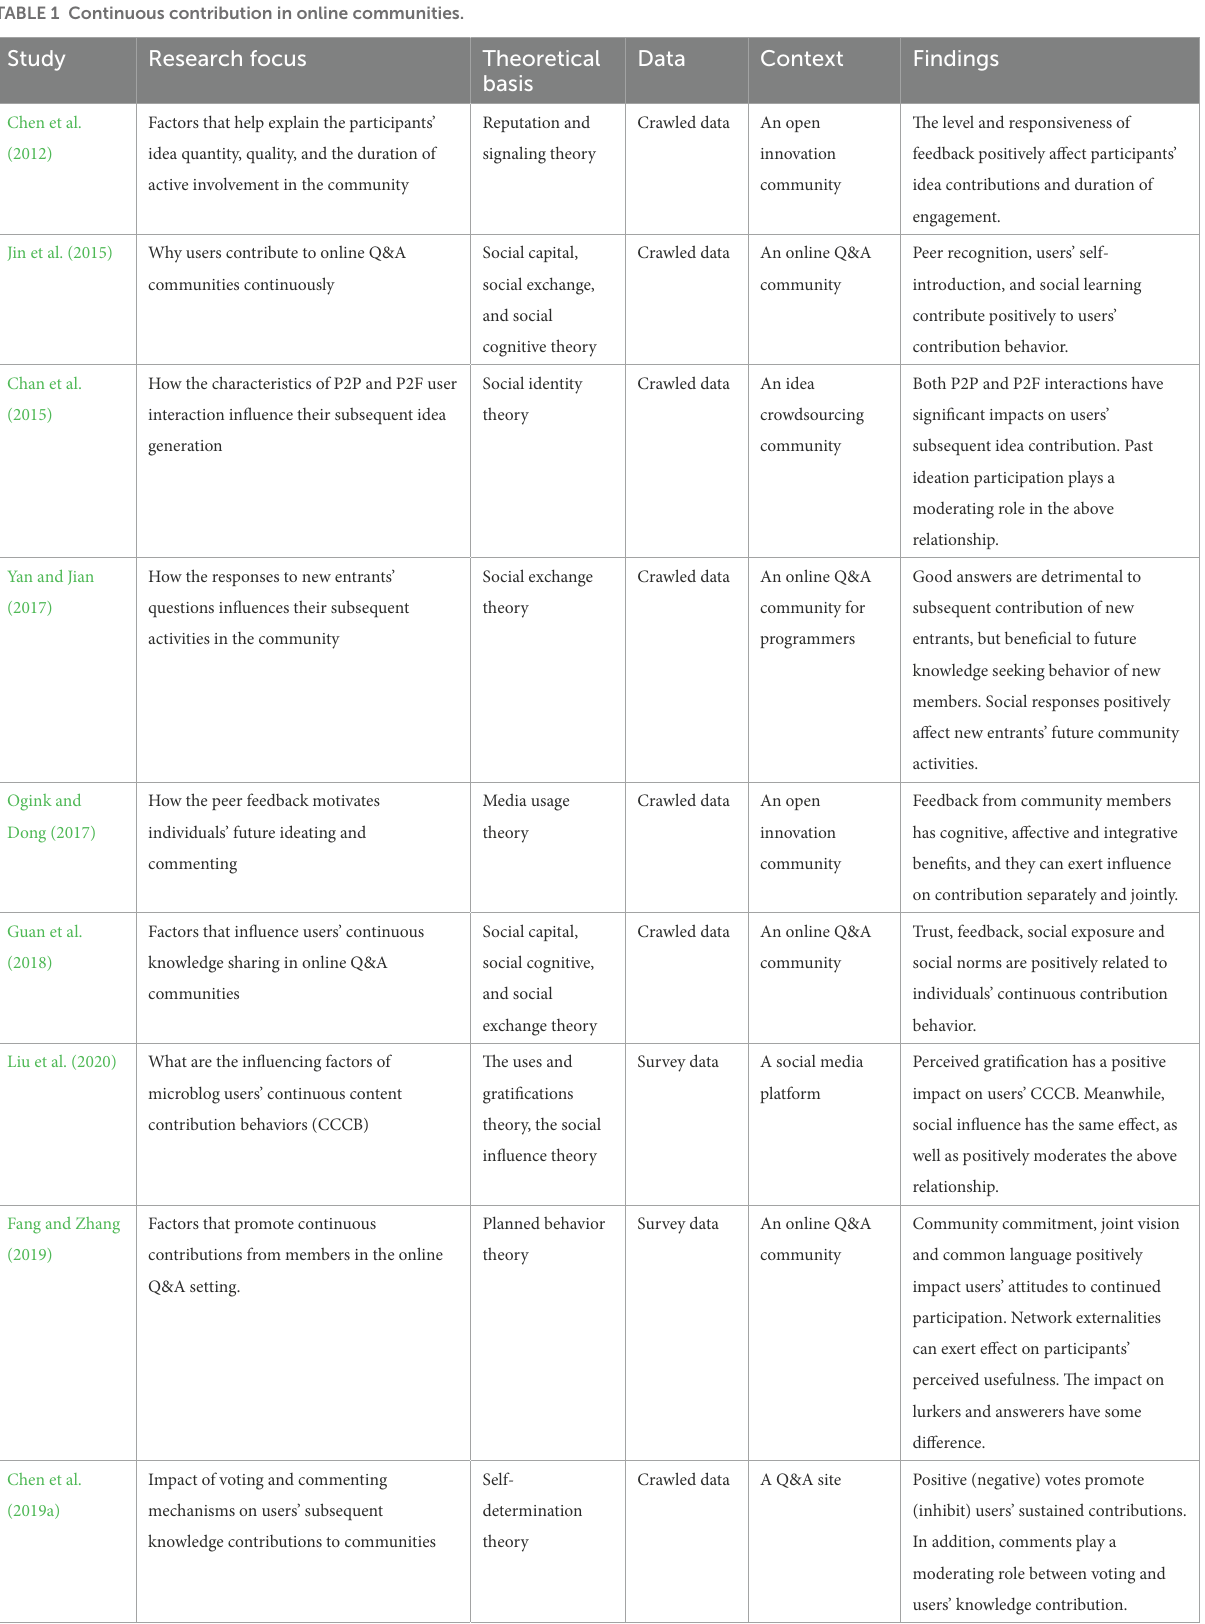
TABLE 1 Continuous contribution in online